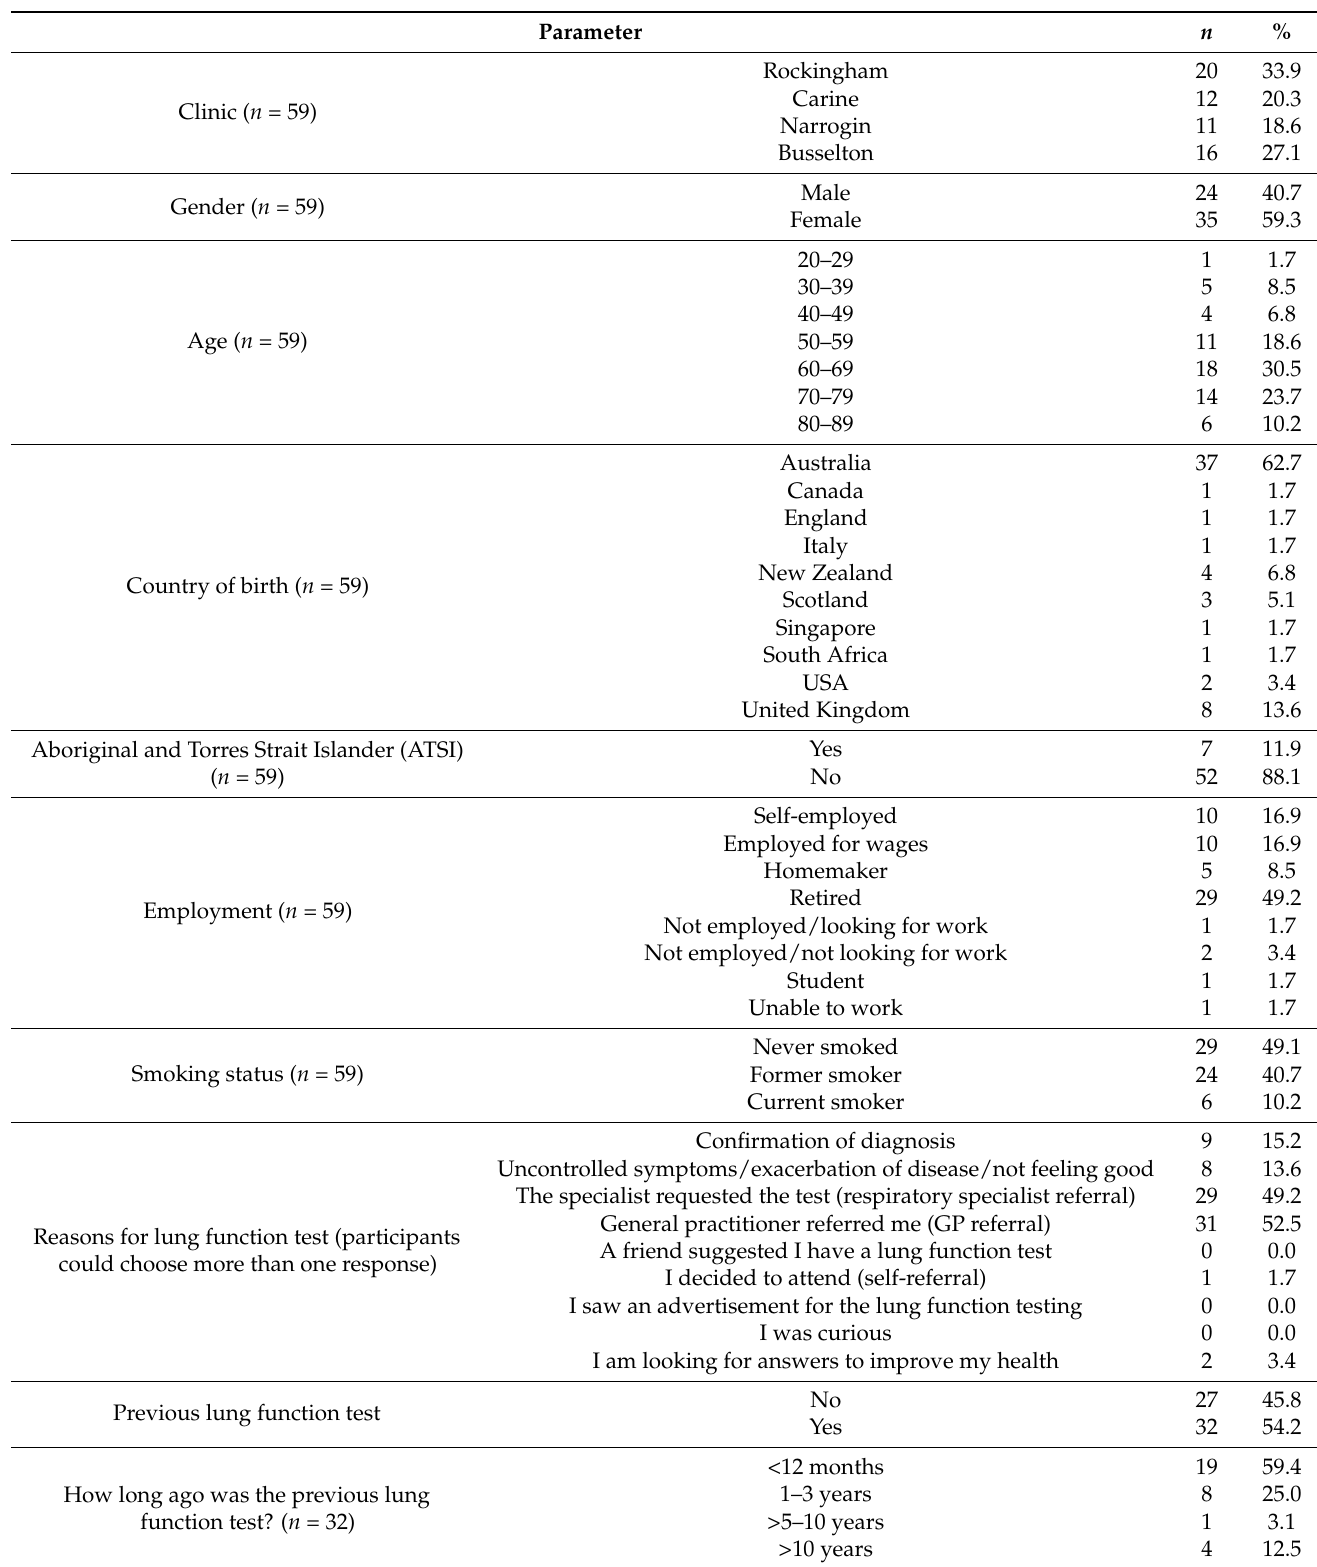
Table 1. Baseline data of participants who had a lung function